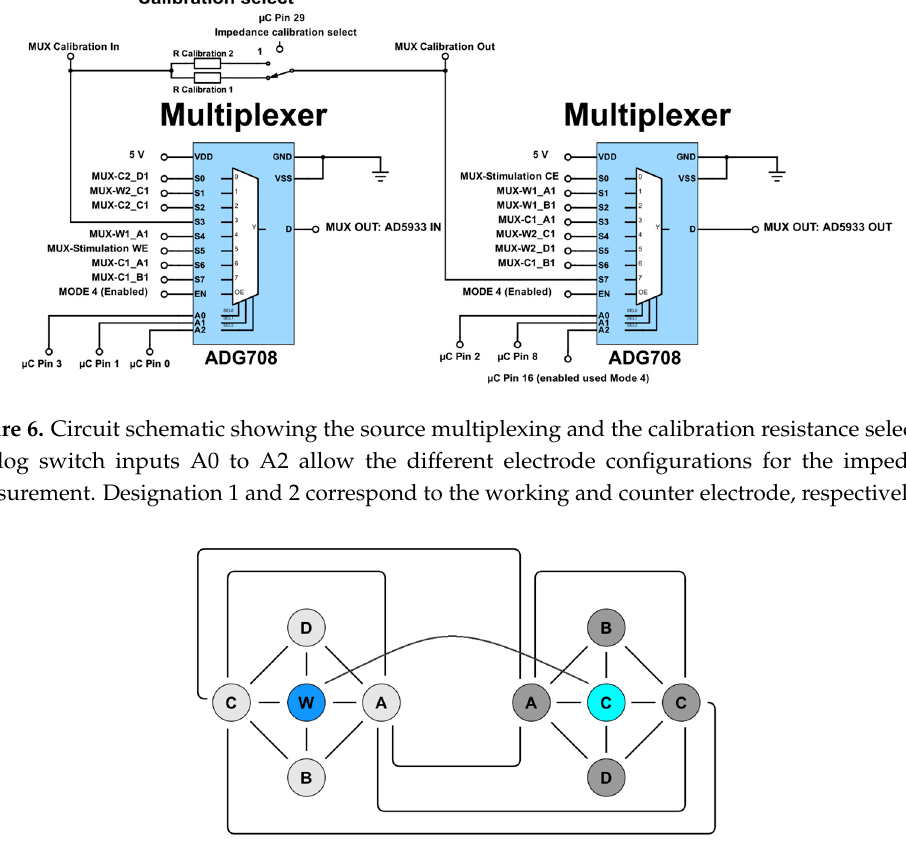
Figure 7. Possible impedance measurements for two multi-sensor arrays. Shown on the left is the working multi-sensor array with four impedance electrodes (A–D) located around the stimulation electrode (W). On the right is the counter multi-sensor array likewise with four impedance electrodes (A–D) located around the stimulation counter electrode (C). Each connecting line represents a possible impedance measurement option.